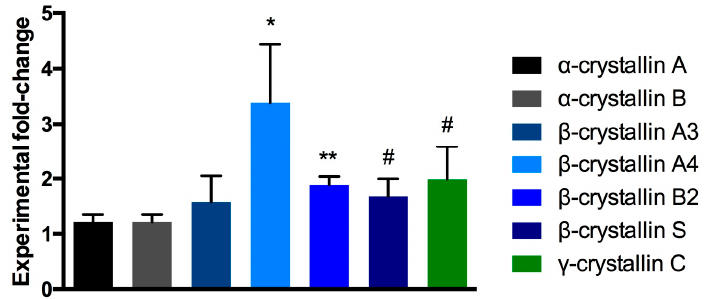
Figure 5. MS fold-change analysis of crystallin protein family members. Injection of α -crystallin B induced moderate to distinct up-regulation of α -, β -, and γ -crystallins in the retina when compared to PBS-injected retinal protein levels (** p < 0.01, * p < 0.05, # p < 0.1, unpaired parametric t -test, n = 4 per exp. group, mean ± SEM).